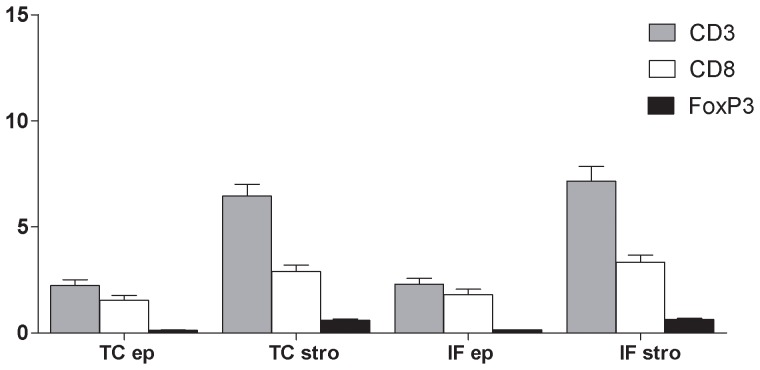
Percentages of tumor-infiltrating lymphocytes in the different areas studied.The bar charts represent the percentages of surfaces marked by CD3, CD8 and FoxP3 immunostaining in the stromal (stro) and epithelial (ep) compartments, in the tumor center (TC) and the invasion front (IF) tissues. Standard errors are given by the bars. CD3+ TIL densities were respectively, 2.2±2.5% in tumor center epithelium compartment, 6.4±5.1% in tumor center stromal compartment, 2.3±2.5% in invasion front epithelium compartment, 7.2±6.1% in invasion front stromal compartment. CD8+ TIL densities were respectively, 1.52±2.0% in tumor center epithelium compartment, 2.9±2.7% in tumor center stromal compartment, 1.8±2.4% in invasion front epithelium compartment, 3.3±3.0% in invasion front stromal compartment. FoxP3+ TIL densities were respectively, 0.13±0.12% in tumor center epithelium compartment, 0.59±0.53% in tumor center stromal compartment, 0.14±0.14% in invasion front epithelium compartment, 0.63±0.58% in invasion front stromal compartment.